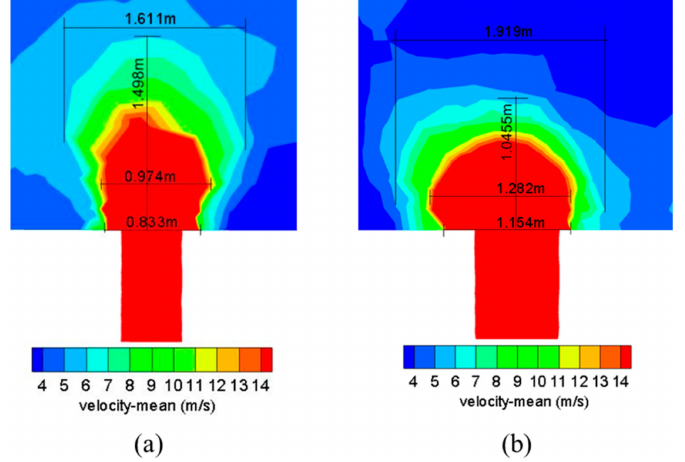
Figure 5. Penetration and diffusion characteristics of SA before and after the SA port correction (( a )—SA jet with actual dimensions; ( b )—SA jet after